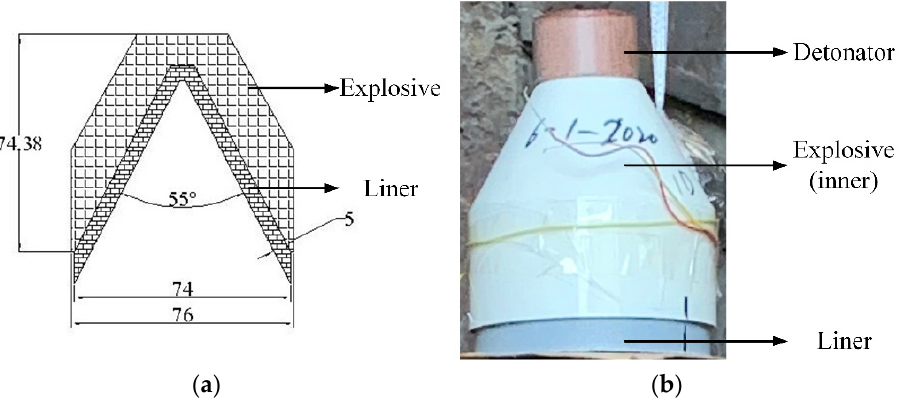
Figure 2. ( a ) Structure sketch of the shaped charge; ( b ) Picture of real products.